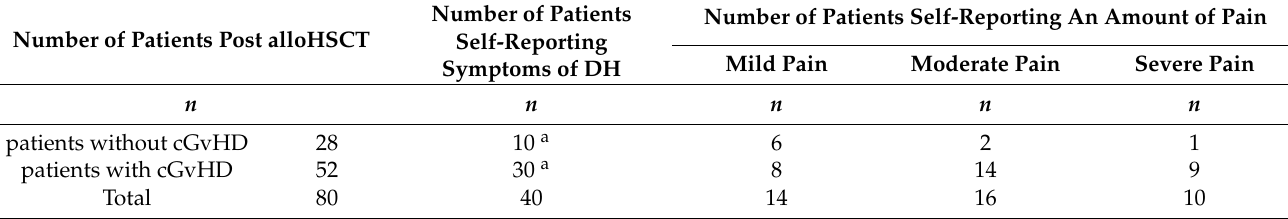
Table 2. Incidence rate and severity of dentin hypersensitivity in post alloHSCT patients, including those suffering from cGvHD—questionnaire results.